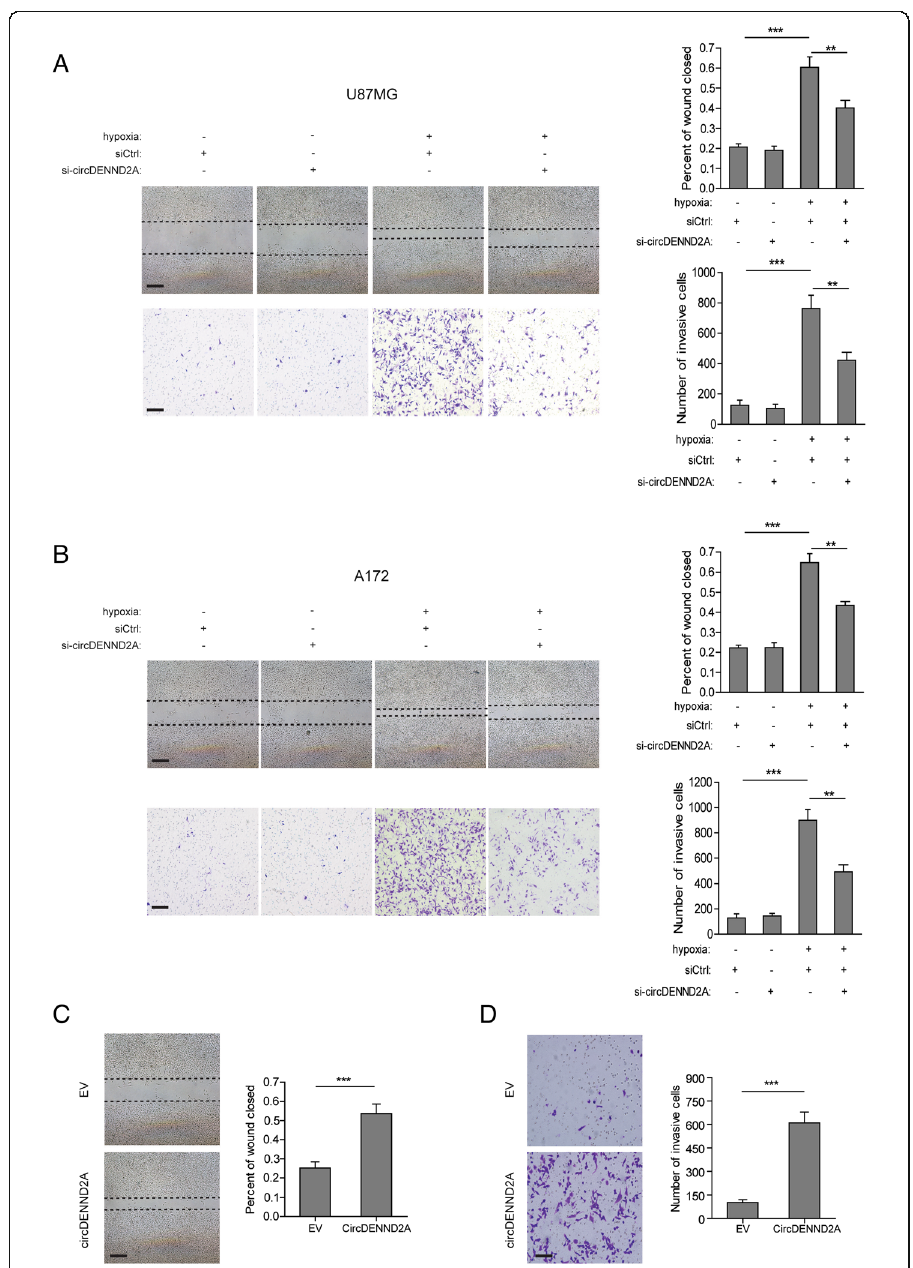
Fig. 2 CircDENND2A contributes to the hypoxia-induced migration and invasion of glioma cells. a and b Left: Representative images from wound healing assays or Transwell assays in normoxic or hypoxic U87MG ( a ) and A172 ( b ) cells with or without knockdown of circDENND2A. Scale bar, 100 μ m. Right: Percentage of wound closure or numbers of invasive cells at 48h after treatment. c and d Left: Representative images from wound healing assays or Transwell assays in U87MG cells with or without overexpression of circDENND2A. Scale bar, 100 μ m. Right: Percentage of wound closure or numbers of invasive cells at 48h after treatment. Data are shown as mean±SD (three independent repeats). * p <0.05, ** p <0.01, *** p